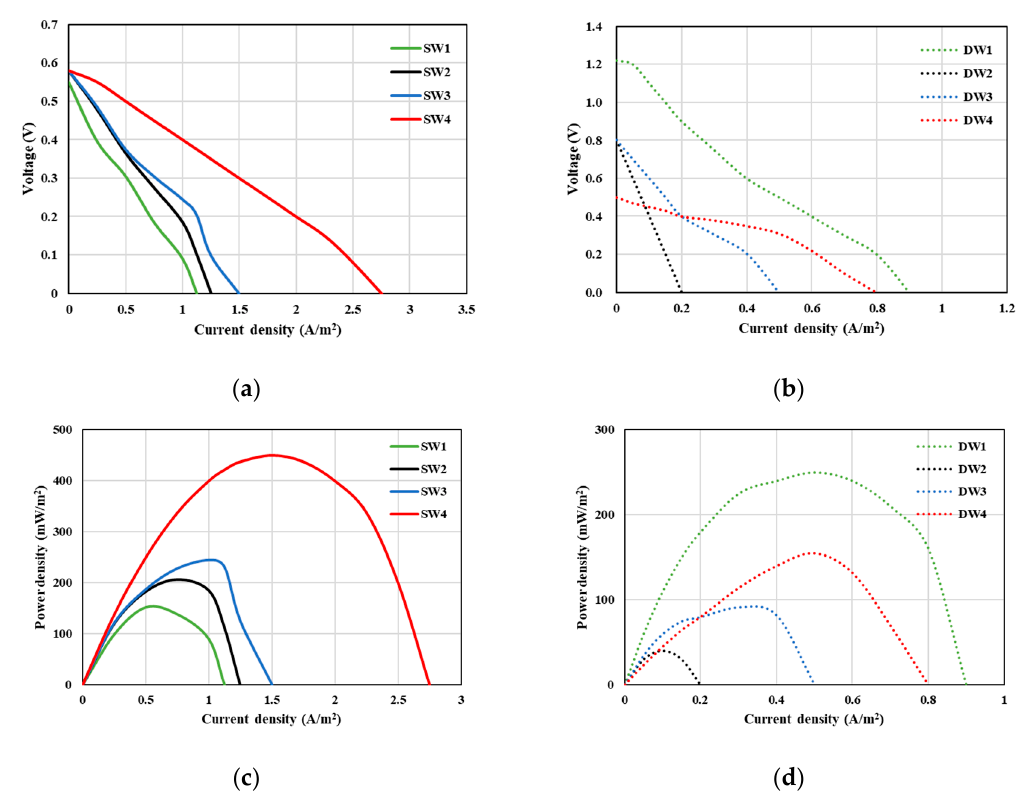
Figure 2. Polarization ( a , b ) and power ( c,d ) curves for EBRs treating synthetic (solid line) and domestic (dotted line) wastewater (WW); ( a ) polarization curve for synthetic WW, ( b ) polarization curve for domestic WW, ( c ) power curve for synthetic WW, and ( d ) power curve for domestic WW.